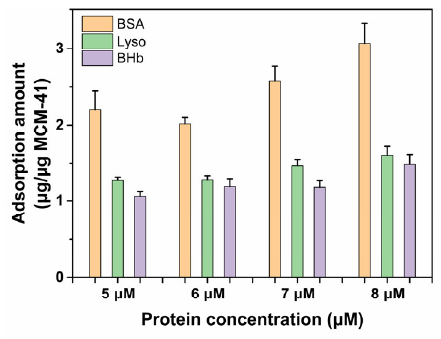
Figure 5. The adsorption amount of different proteins on MCM ‐ 41 at different concentrations.